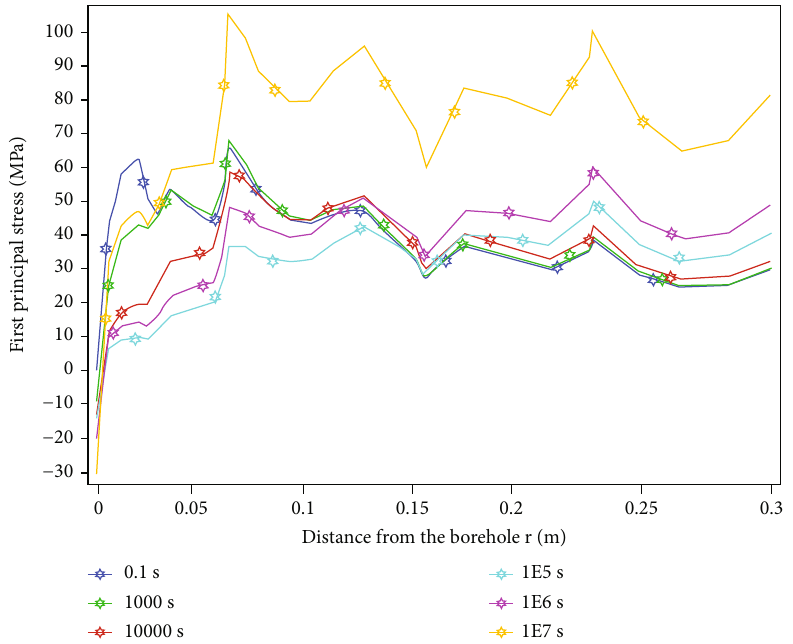
Figure 22: First principal stress in the m = 3 coal rock during CBM production.